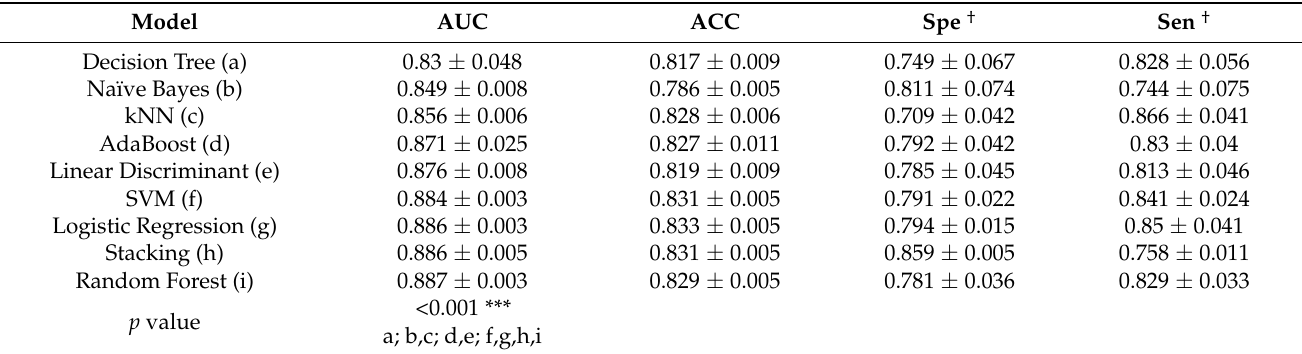
Table 3. The top three importance predictors in the random forest machine-learning model to predict